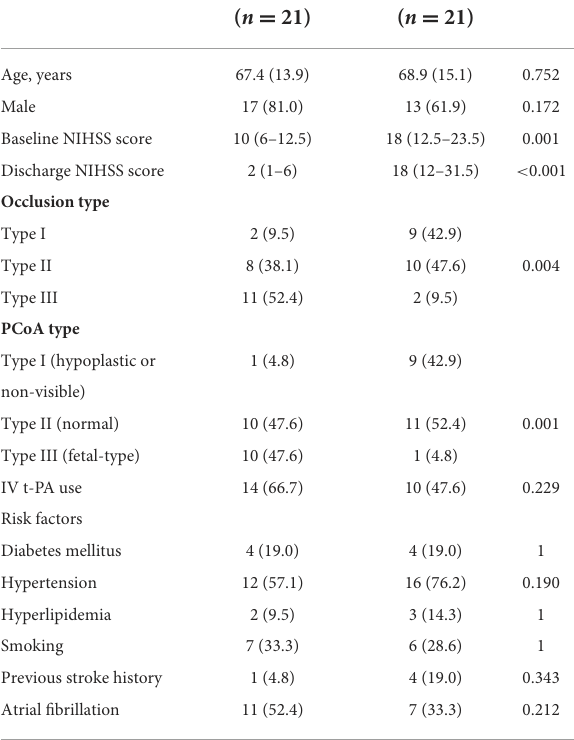
TABLE 1 Comparison of baseline characteristics between patients TABLE 2 Comparison of procedural and clinical data between patients with favorable (mRS ≤ 2) and poor (mRS > 2) outcomes. with favorable (mRS ≤ 2) and poor (mRS > 2) outcomes. Favorable outcome Poor outcome P value Favorable outcome Poor outcome P-